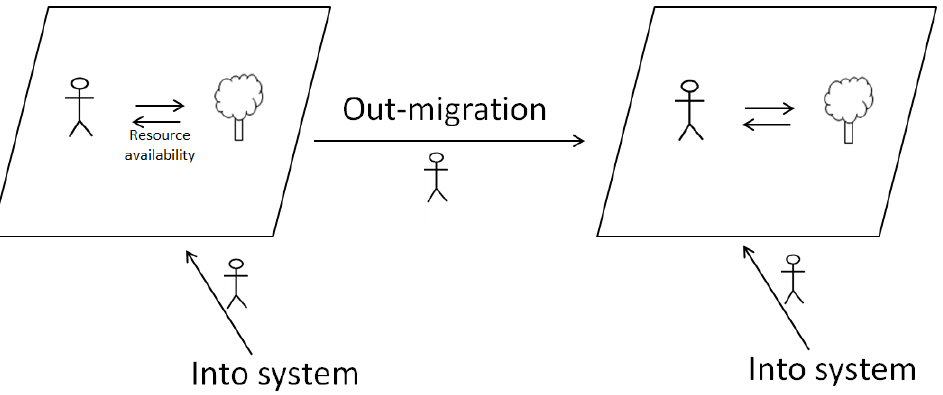
Fig. A1.2 Diagram drafted for the ABM described by Hadzibeganovic & Xia (2016); the model includes two types of migration decision („reproduction-based“ and „payoff-based“) of which one is with knowledge of the destination system (i.e.